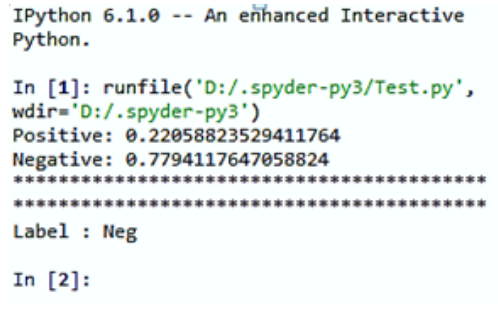
Figure 3. Result of the analysis of a